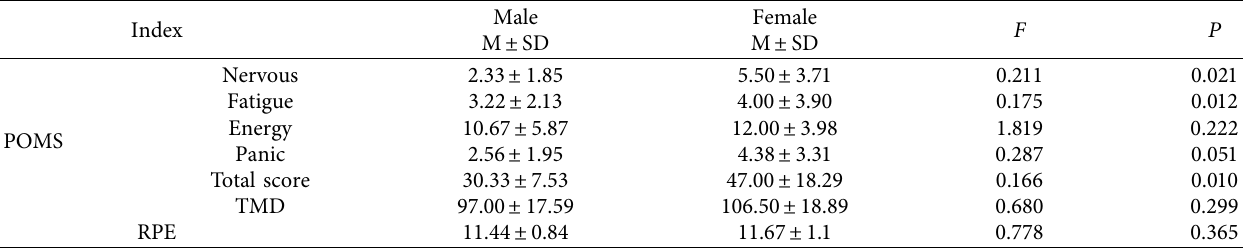
Table 1: Difference test table of POMS components and RPE for male and female athletes.